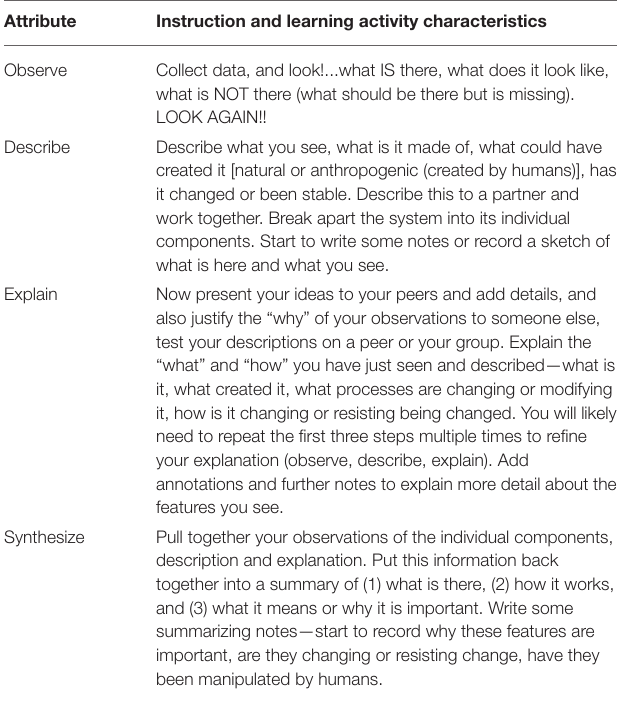
TABLE 4 | The ODES framework (from a field handbook as given to students for a field exercise). Attribute Instruction and learning activity characteristics